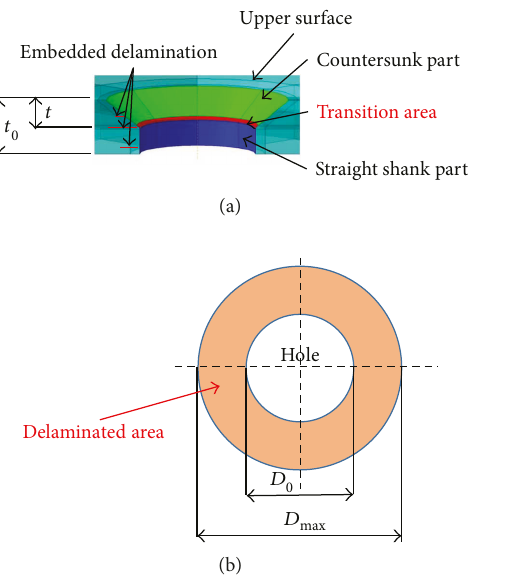
Figure 9: (a) A schematic diagram of the countersunk hole. (b) Uniform delaminated area around the hole.